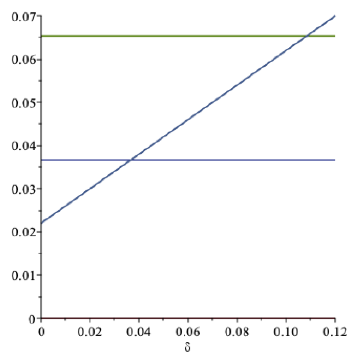
Figure 2. The drawdown rate k ( δ , γ ) as a function of δ when γ = 2.5.